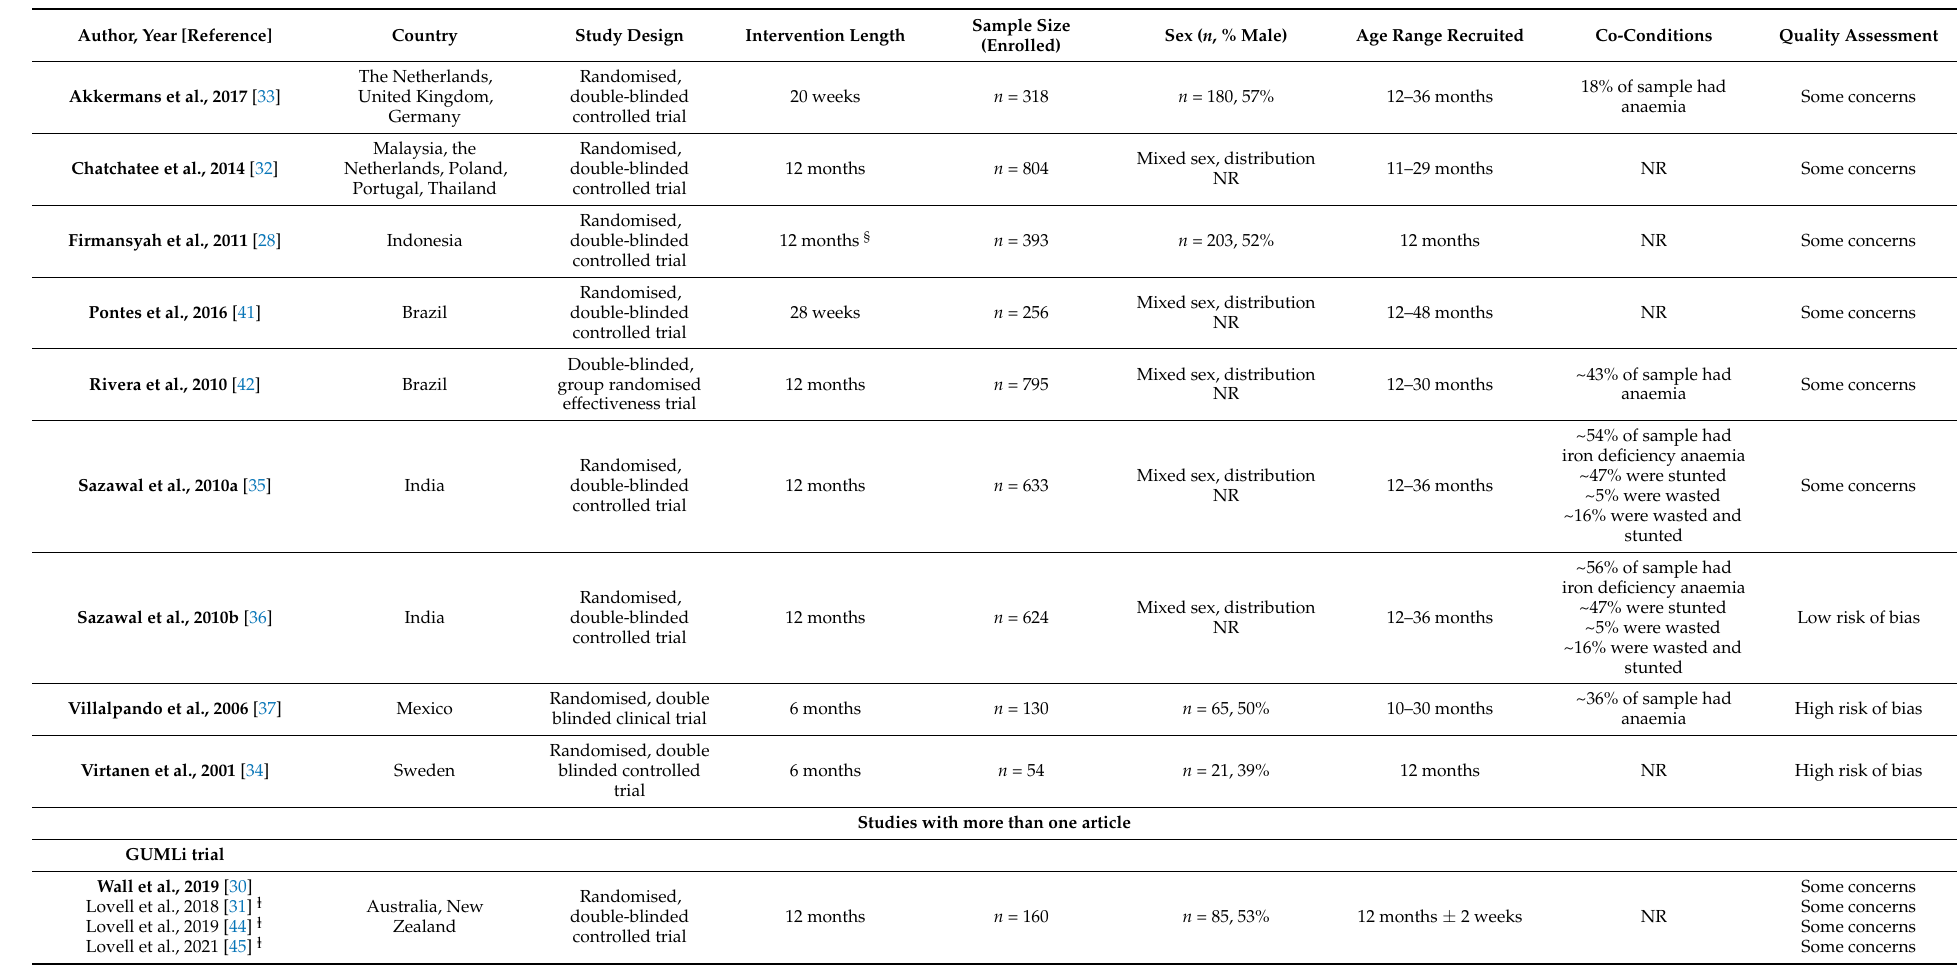
Table 2. Characteristics of included